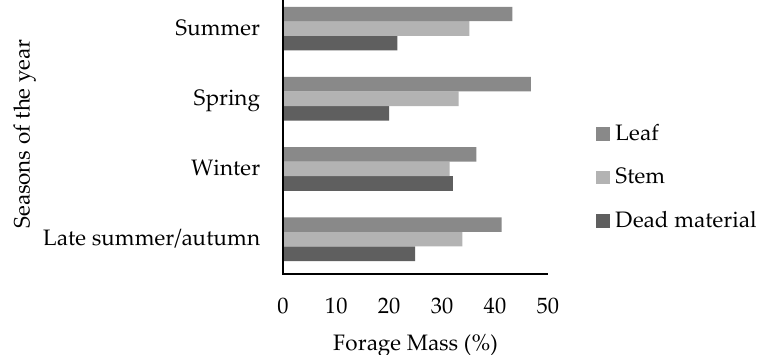
Figure 4. Percentage components of pre-grazing forage mass of Brachiaria brizantha cv. Piatã under rotational stocking fertilized with nitrogen throughout seasons of the year.